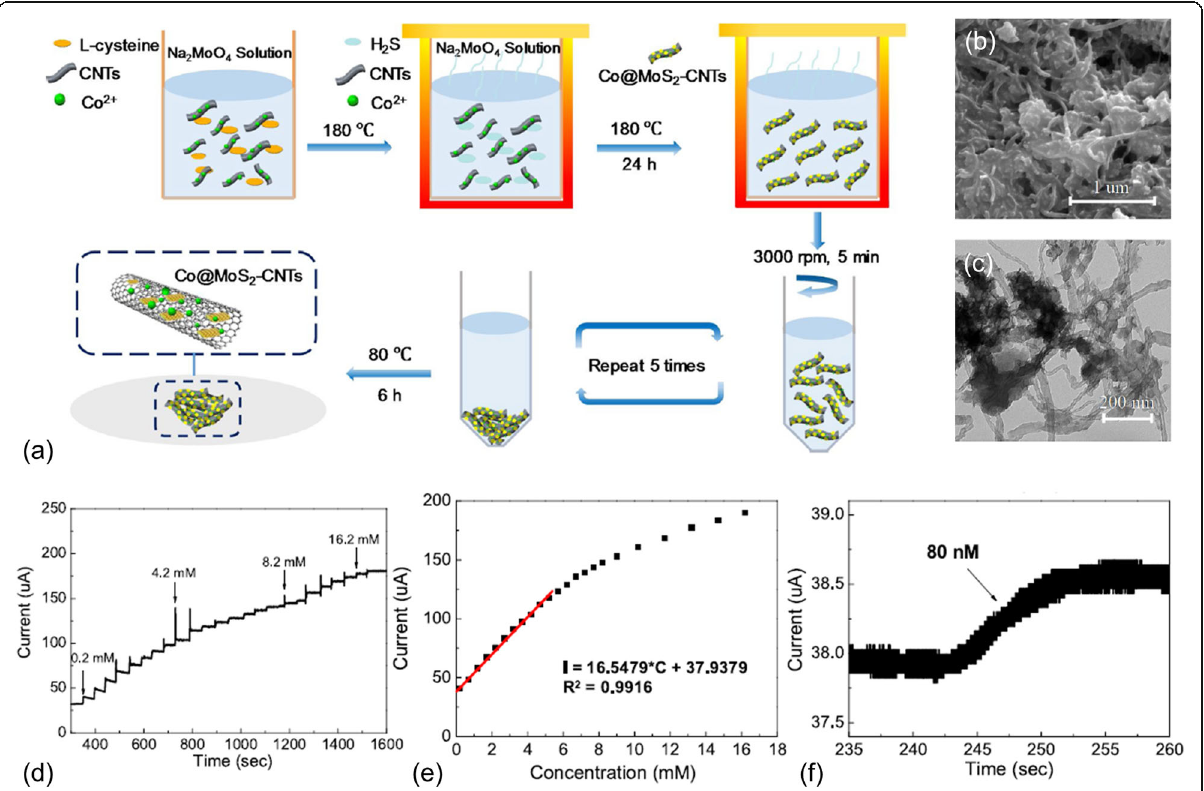
Fig. 2 a Schematic diagram of the hydrothermal assembly of Co-MoS2/CNTs. b SEM and c TEM images of the synthesized Co-MoS2/CNTs. d Amperometric responses of the Co-MoS 2 /CNT sensor to the successive addition of glucose. e The extracted response current to different glucose concentrations. f Amperometric curve of the Co-MoS 2 /CNT sensor to 80 nM glucose. Reprinted from [29], Copyright 2019, with permission from